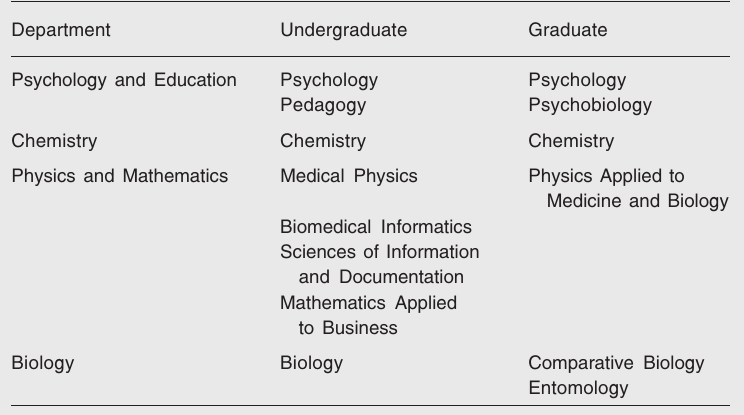
Table 1. List of undergraduate and graduate programs belonging to the departments of Psychology and Education, Chemistry, Physics and Mathematics, and Biology of the Faculdade de Filosofia, Ciências e Letras de Ribeirão Preto, Universidade de